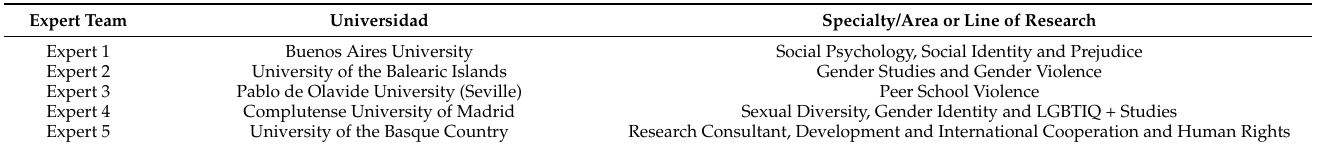
Table 4. Expert team members’